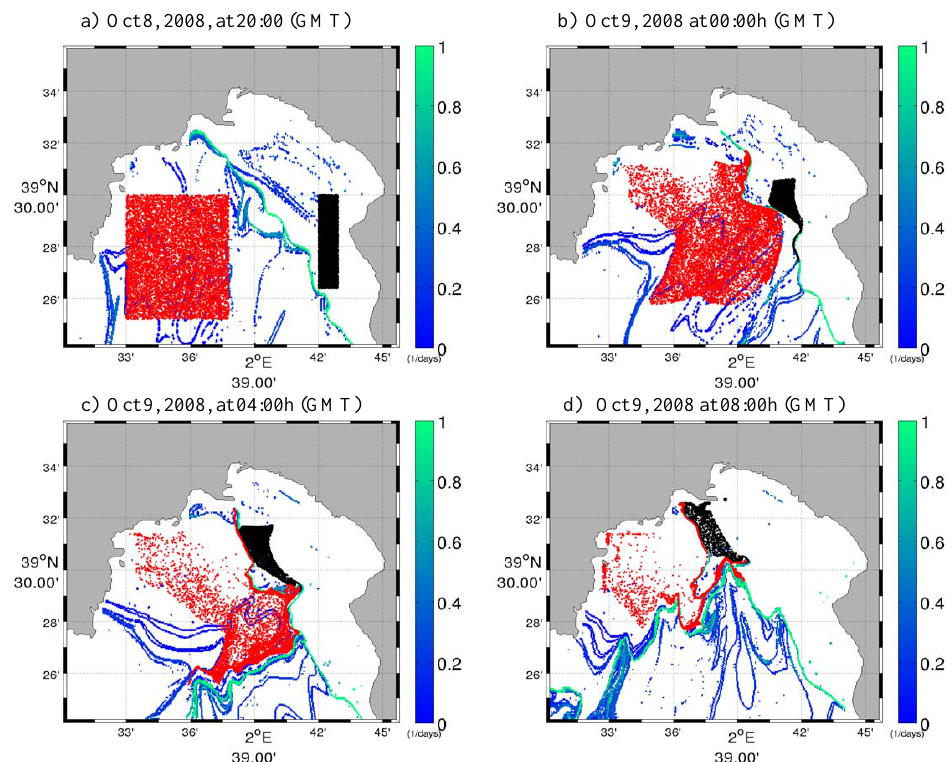
Fig. 5. Evolution of the locations of two sets of particles in the Bay of Palma during a night in October, superimposed on the spatial distributions of high values of backward FSLEs. The color bars specify FSLE values (in units of day − 1 ). Zero FSLE values, displayed as white, are assigned to locations for which the particles do not attain the prescribed δ f = 10km separation after 5 days of integration. Note the highest values of FSLEs (green lines) act as a barrier practically dividing the bay in two parts. The two sets of particles are deployed from both sides of the barrier. (a) Initial conditions of the particles on 8 October 2008 at 20:00 GMT (Greenwich mean time); (b) 9 October 2008 at 00:00 GMT; (c) 9 October 2008 at 04:00 GMT; (d) 9 October 2008 at 08:00 GMT. Particles marked by black dots were released on the right side (northeast) of the barrier while the particles marked with red were released on the left side of the barrier.